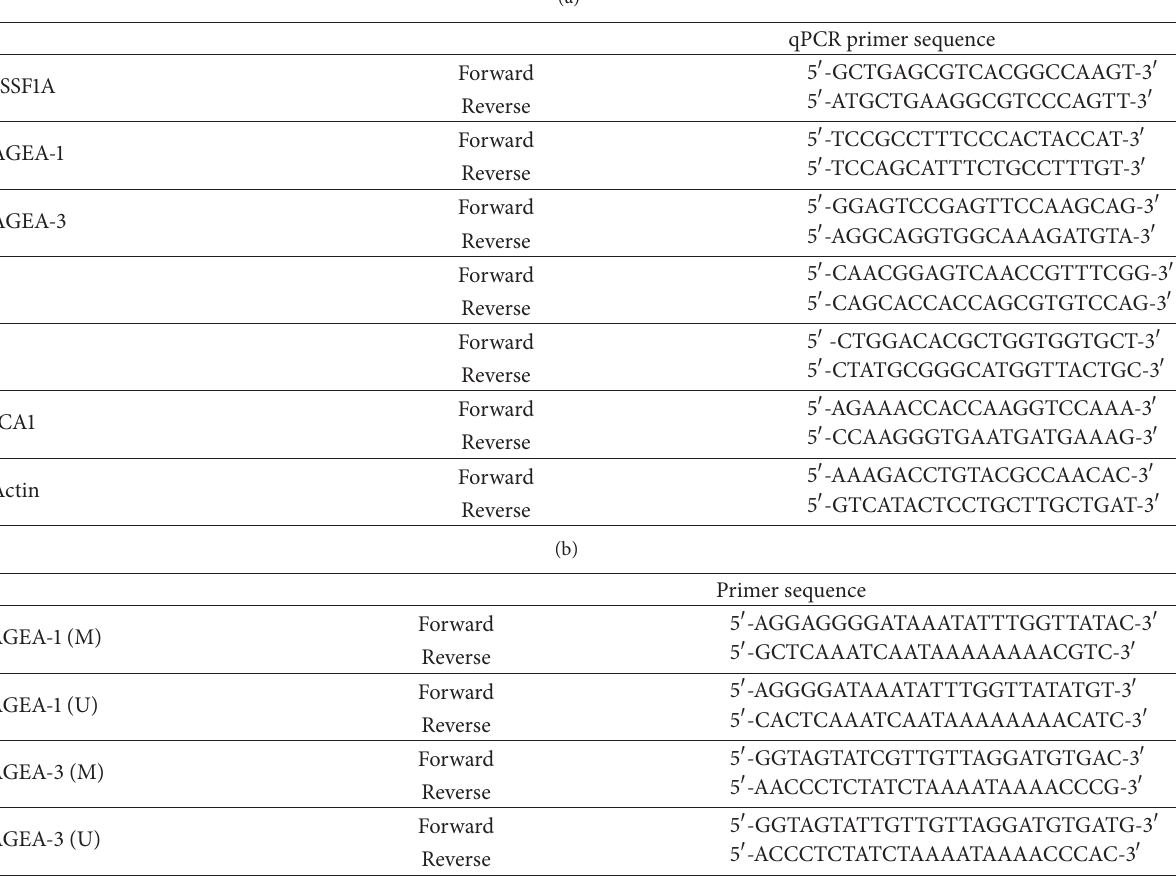
Table 6: (a) Primer sequence for qPCR. (b) Primer sequence for methylation